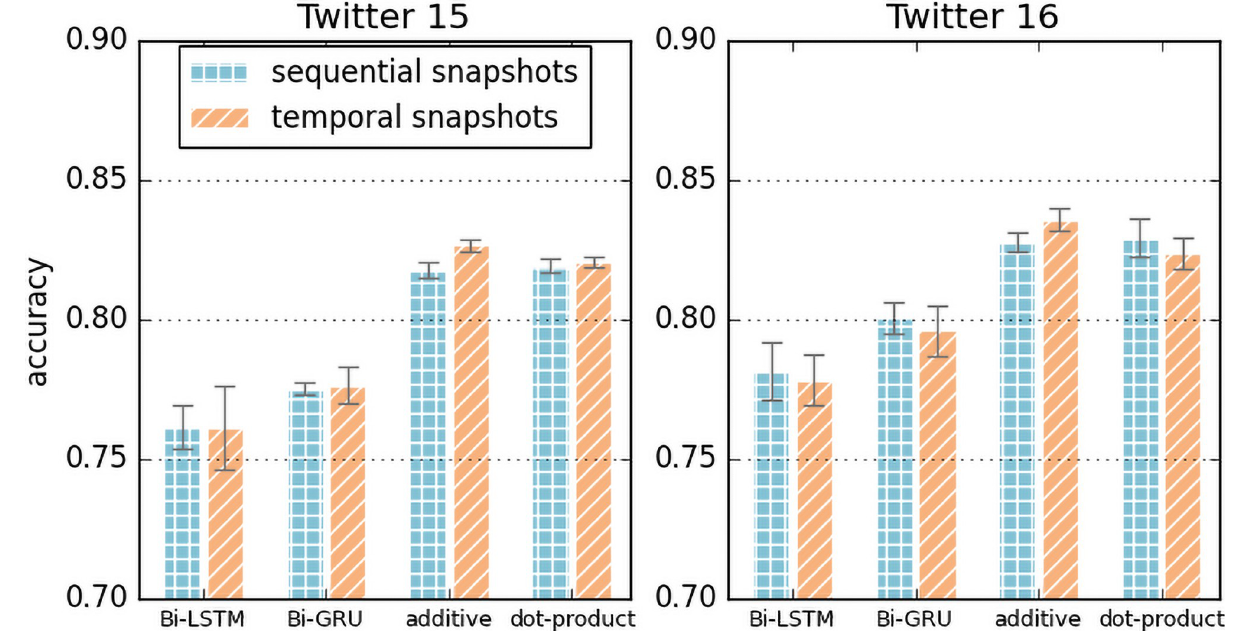
Fig 5. Differences in accuracy of various sequence learning